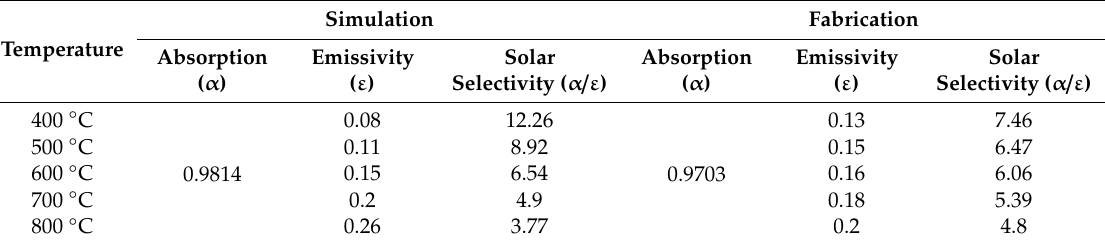
Table 2. Calculated absorption and emissivity of a solar selective